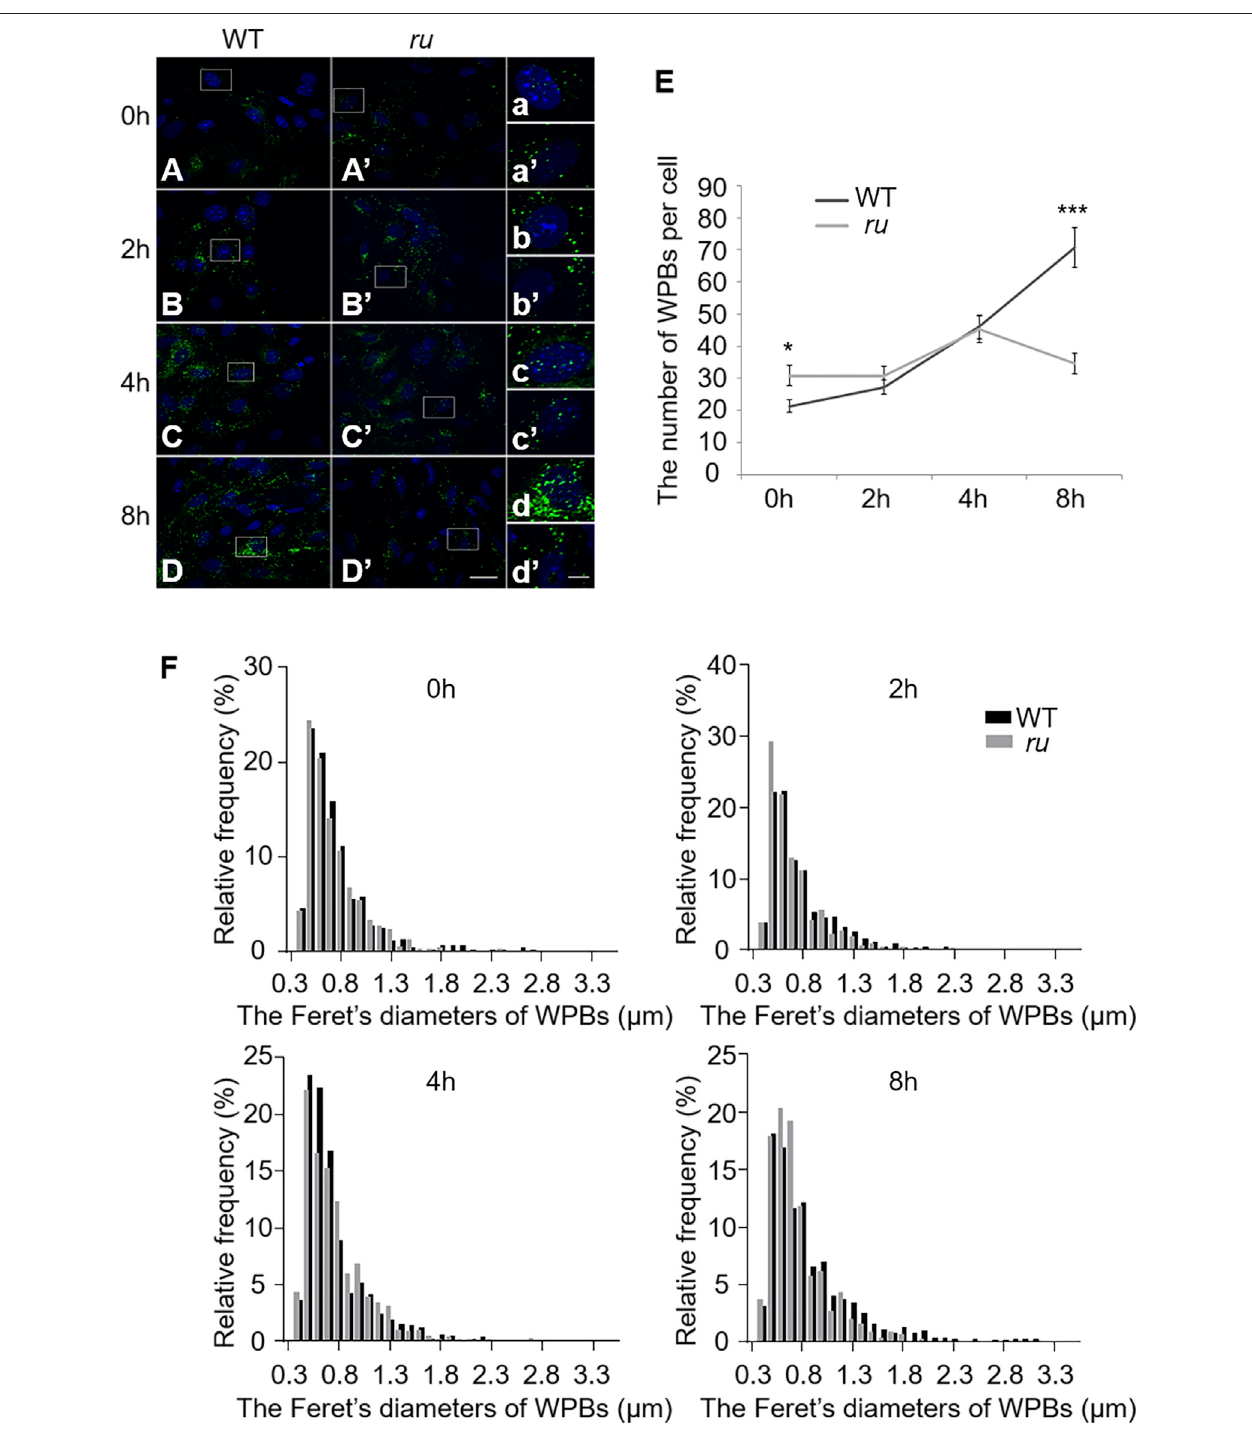
FIGURE1| Thenumberandtheelongatedshapeofnewlyformed Weibel – Paladebodies(WPBs)areaffectedin ru endothelialcells(ECs). Primaryendothelial cells wereisolated from 4-week-oldmale WT and ru mice and cultured for10 days, then 80 nM PMA wasadded toeach dish tostimulate WPB secretion for30 min, and the cells were fi xed at 0, 2, 4, and 8 h after washing out. ( A – D ) ( A 9 – D 9 ) Immuno fl uorescence images of primary endothelial cells at different time points labeled against vWF (green) and nucleus (DAPI, blue). Scale bar, 20 μ m. The boxed square in ( A – D ) and ( A 9 – D 9 ) was magni fi ed as (a – d) and (a ′ -d ′ ), respectively. Scale bar, 5 μ m. ( E ) Quantitative analysis of the number of WPBs in each cell of WT and ru mice at different time points ( n = 20, * p < 0.05, *** p < 0.001). ( F ) Feret ’ s diameter distribution of WPBs at each time point in WTand ru mice wasanalyzed quantitatively(WT 0h : 428WPBs, ru 0h : 616WPBs, WT 2h : 545WPBs, ru 2h : 612WPBs, WT 4h :921 WPBs, ru 4h : 903 WPBs, WT 8h : 1,412 WPBs, and ru 8h : 692 WPBs). All the images were analyzed by the NIH ImageJ software. Data were expressed as mean ± SEM. Two independent experiments were performed.